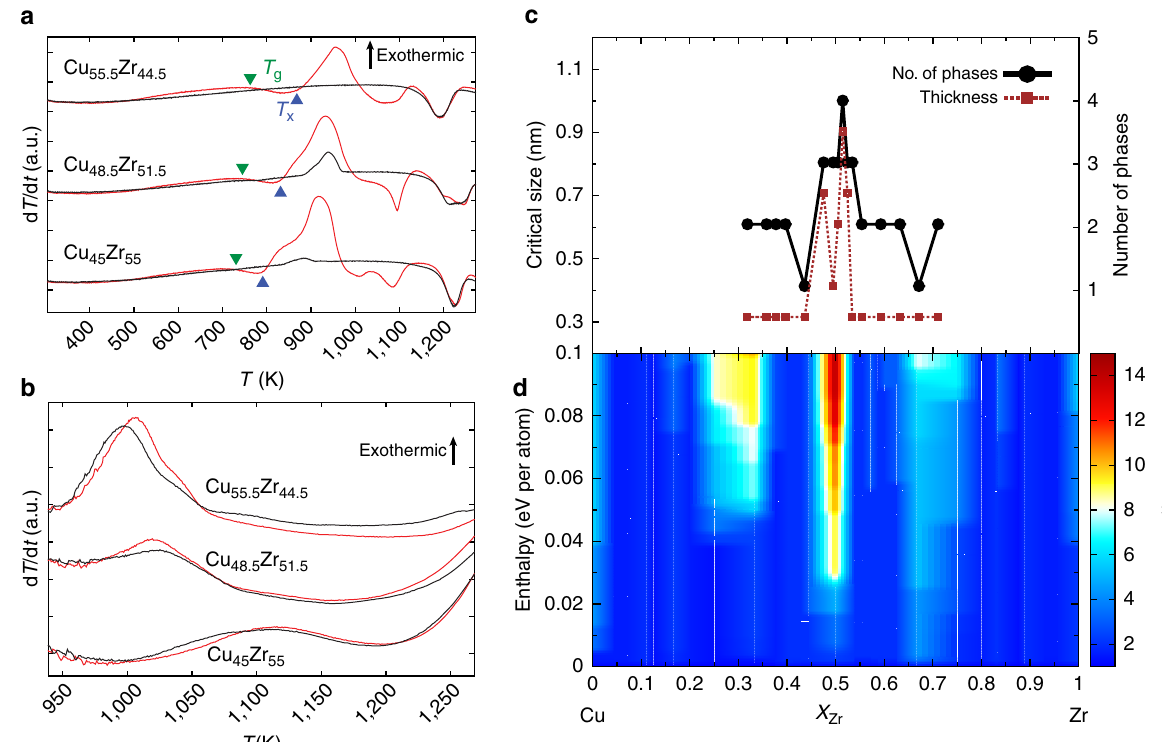
Figure 3 | Experimental and theoretical analysis of CuZr. ( a ) Nanocalorimetry measurements during heating and ( b ) cooling at different compositions. The first heating and cooling cycle measurements for the each composition are shown in red, and subsequent measurements are shown in black. ( c ) Number of phases (solid black line) as measured using X-ray diffraction, and thickness of the amorphous phase (dashed brown line), determined from the wedge shaped samples, as a function of composition. ( d ) Contour plot of the entropic factor as a function of formation enthalpy (zero corresponds to the ground state of the composition). The colour scale represents the entropic factor, calculated using equation (1), for each composition and formation enthalpy difference. This means that for a given fixed composition ( x axis) all phases that are within a given formation enthalpy difference ( y axis) from the ground state of that specific composition are used to compute the entropic factor (colour scale). Note the sharp peaks both in the number of states observed in experiment and in the entropic factor at the Cu 50 Zr 50 composition, indicating that the descriptor correctly identifies this composition as having the highest